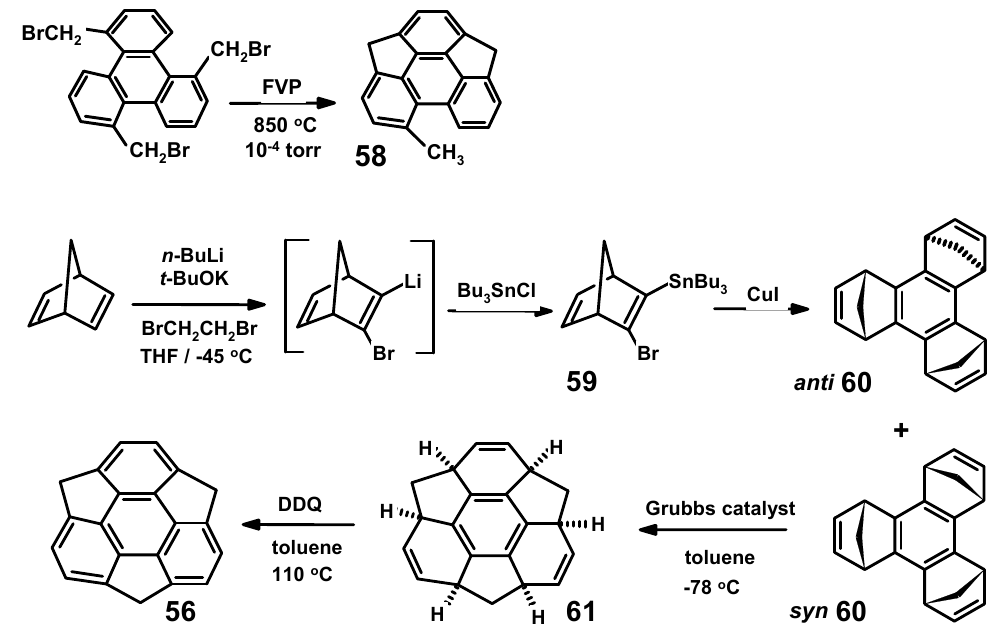
Figure 10. Inversion of corannulene, 55 , can be monitored via the diastereotopic methyls in 57 . Initial attempts to prepare bowl-shaped sumanene from planar 1,5,9-tris(bromomethyl)triphenylene by flash vacuum pyrolysis (FVP) only yielded the doubly bridged prod- uct 58 [36]. Success was finally achieved by copper-mediated trimerization of 1-bromo-2- tributylstannylnorbornadiene, 59 , to give a 3:1 mixture of anti and syn benzotris(norbornadiene), 60 . As shown in Scheme 21, the latter isomer underwent metathesis with a Grubbs catalyst to yield hexahydrosumanene, 61 , that was oxidised with DDQ to furnish the final product [37].